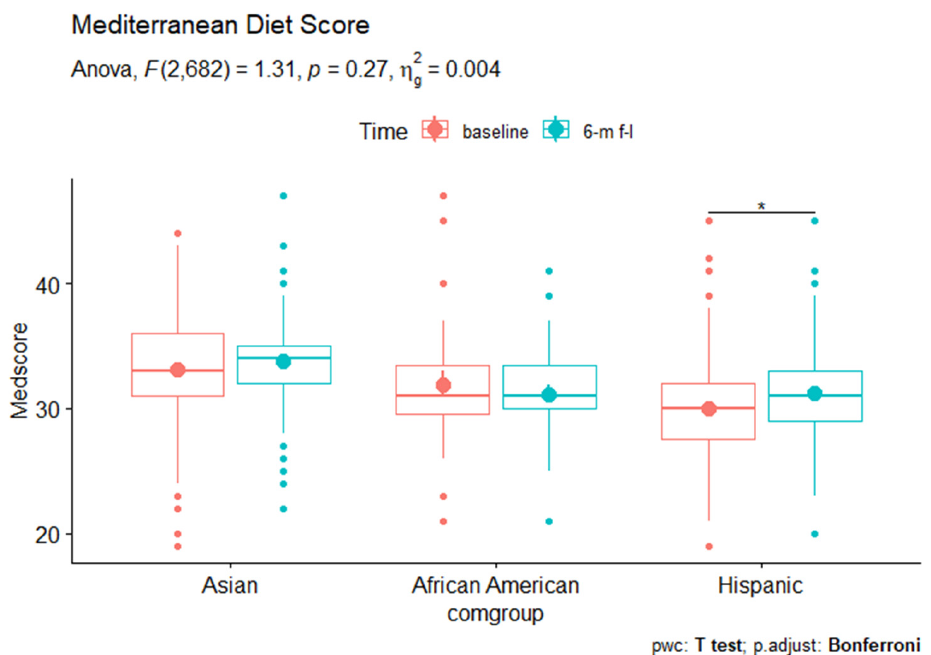
Figure 1. The Mediterranean diet scores among Asian American, African American, and Hispanic subgroups at baseline vs. 6 m follow up. * p < 0.05.